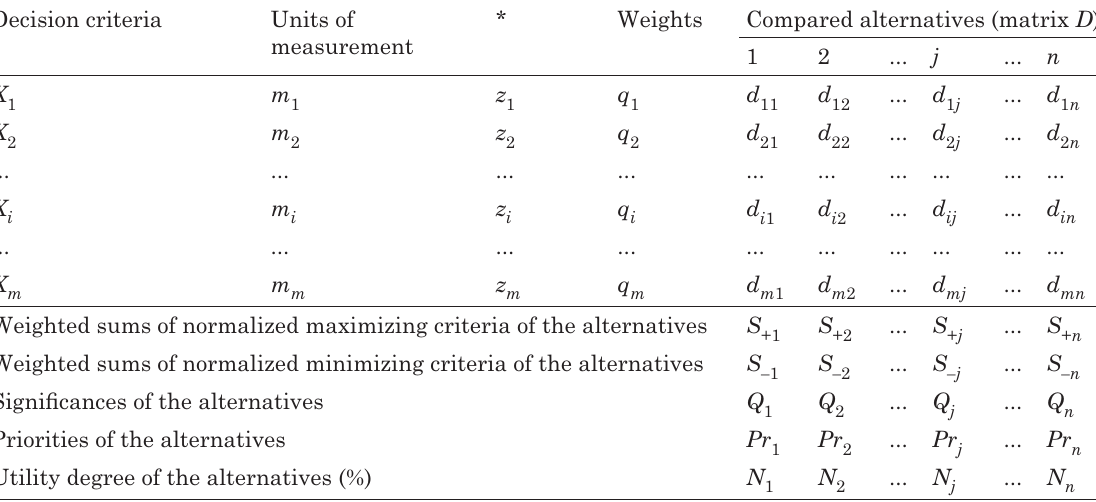
Table 3. Decision-making matrix for multiple criteria analysis Decision